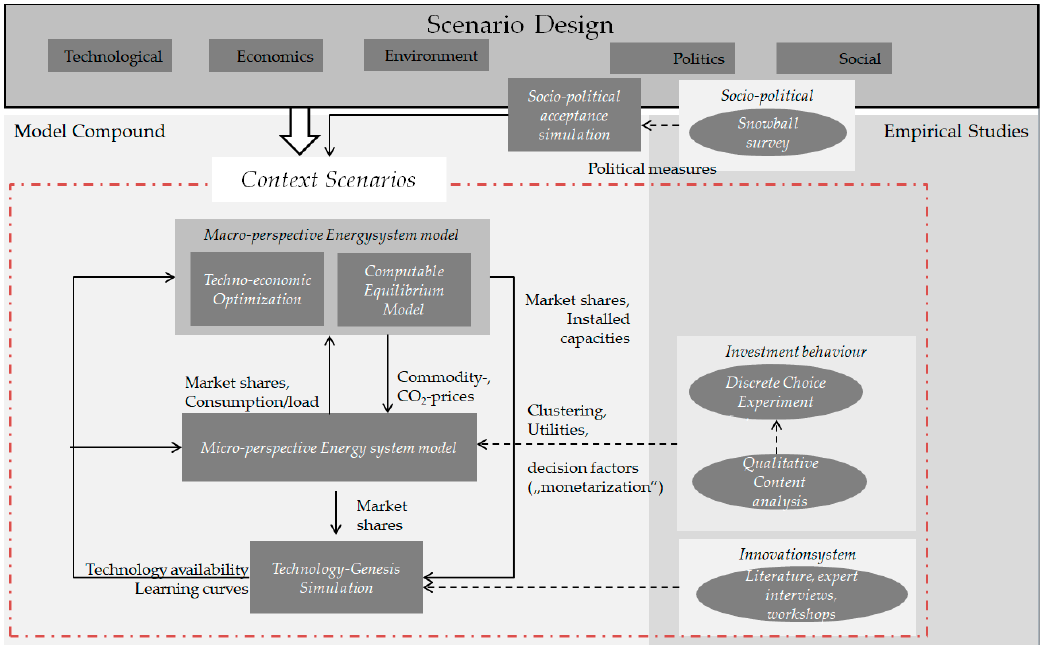
Figure 2. Schematic overview of possible interactions of the energy system model (macro-perspective), transformation path model (micro-perspective), technology genesis model (innovation) and socio-political acceptance model.